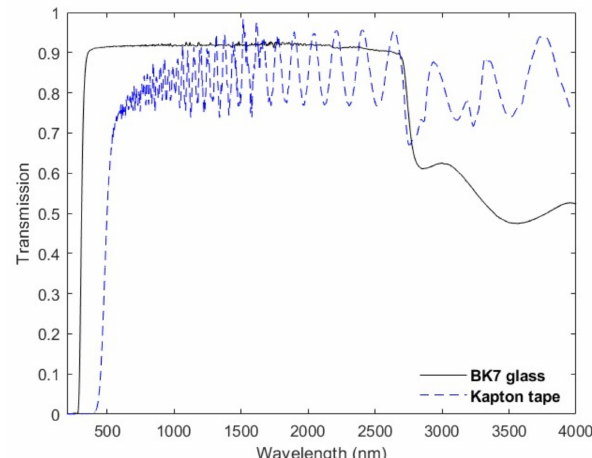
Figure 2. Transmission spectra of BK7 glass substrate (solid black) and Kapton ® tape (dashed blue) over visible to infrared (IR) wavelengths (400 to 3500